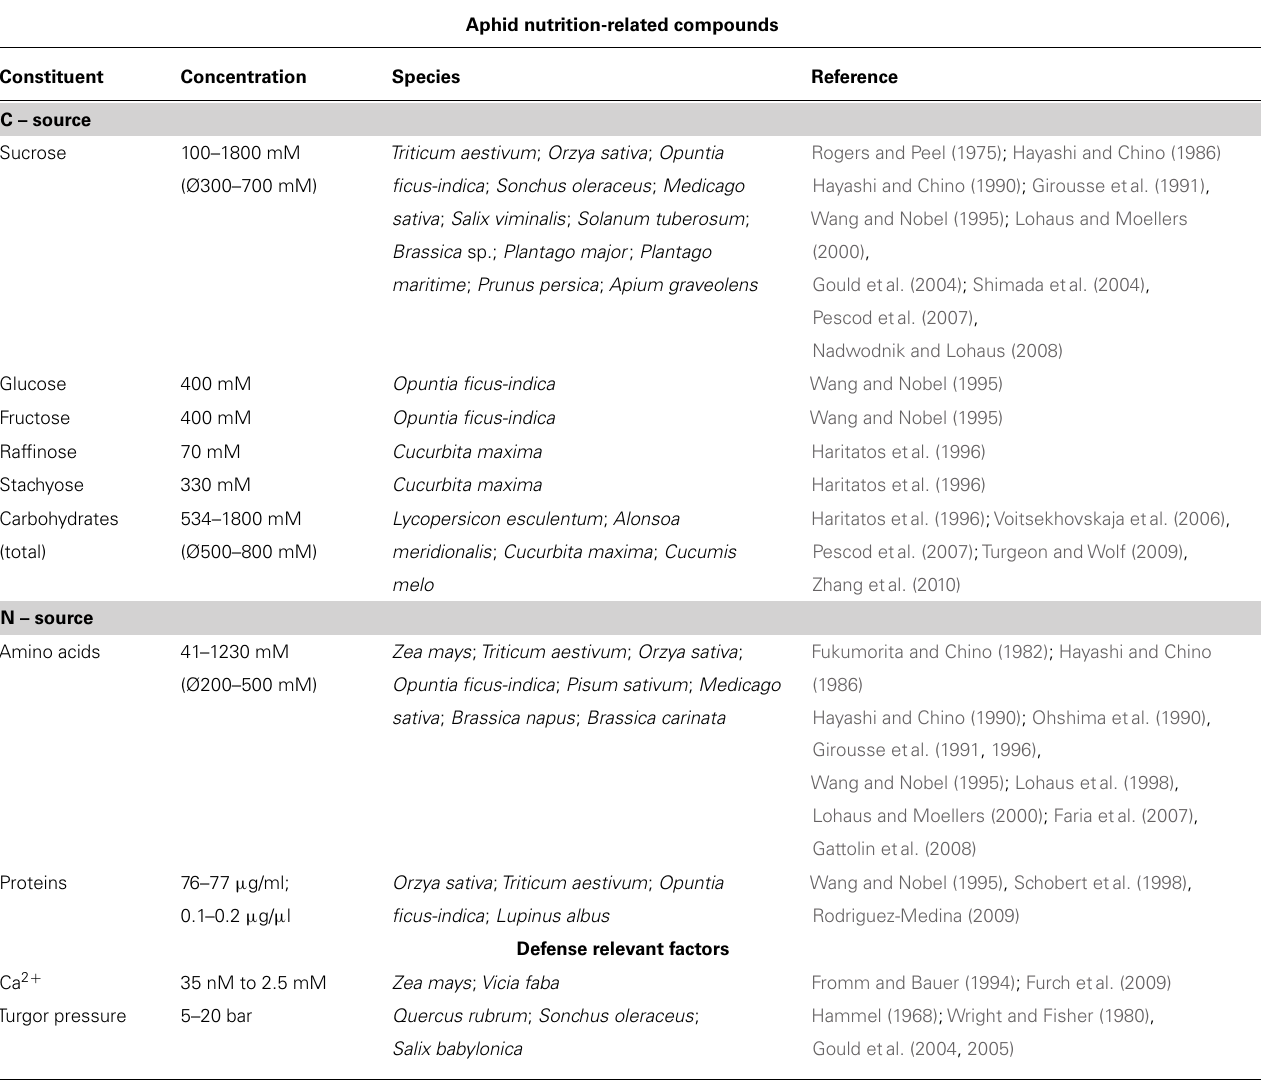
Table 1 |Aphid nutrition-related compounds and defense relevant factors of phloem